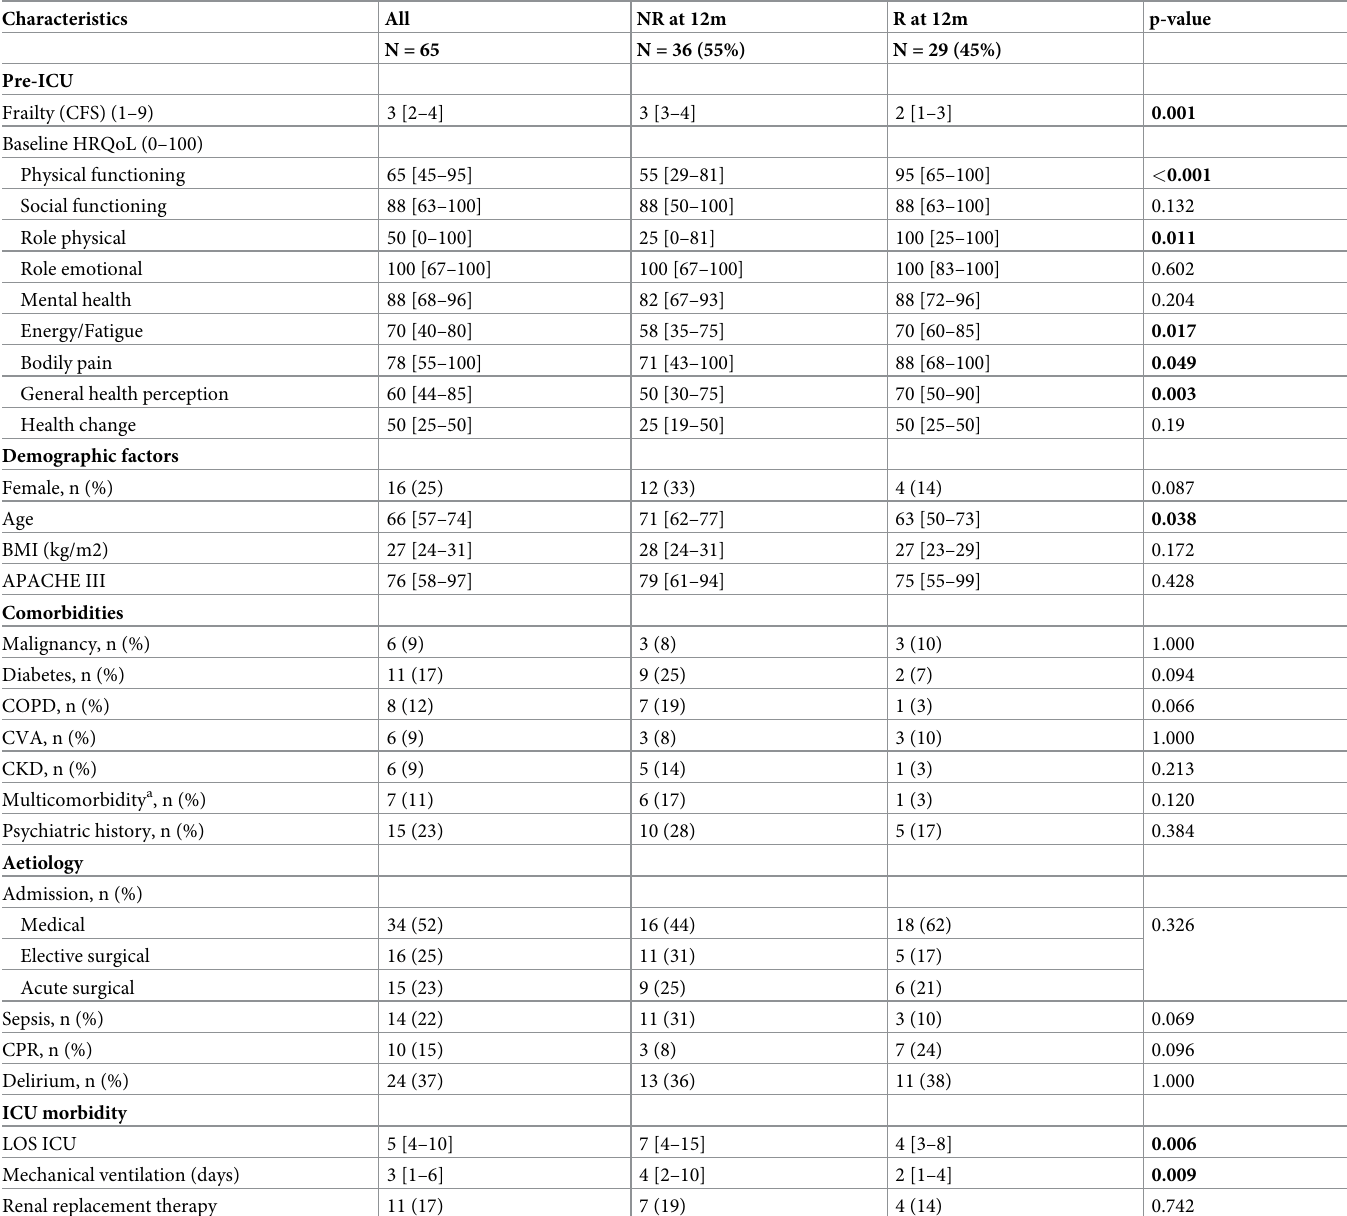
Table 1. Comparison of group characteristics at baseline and after ICU admission.